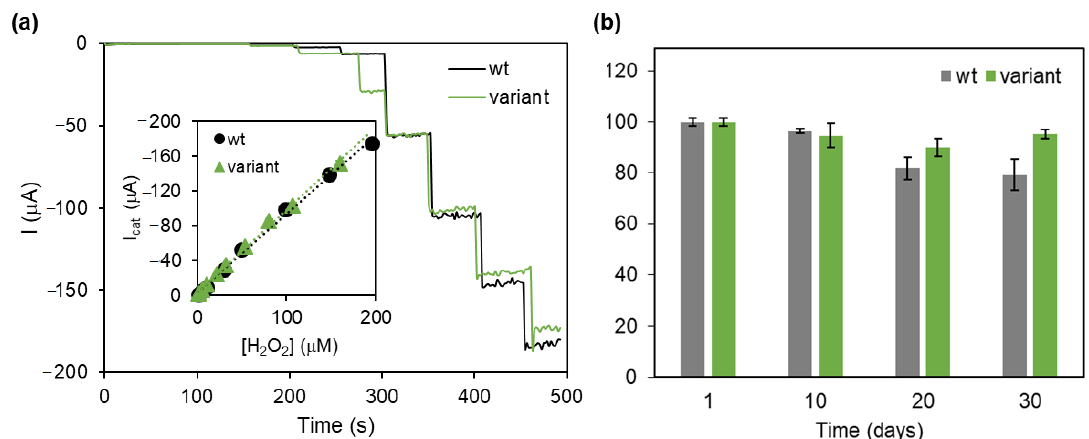
Figure 7. Catalytic response and stability of a dye-decolorizing peroxidase (DyP)/SAM/Ag biosensor used for H 2 O 2 quantification. ( a ) Amperometric response of wild-type (wt) and variant DyP-based biosensors to increasing H 2 O 2 . Inset : Calibration plots showing the linear dependence of the catalytic current on H 2 O 2 concentration. ( b ) Relative catalytic current response to 50 μM H 2 O 2 during storage for one month, measured on a batch of electrodes prepared on the same day (shelf-life). Reprinted from Barbosa et al. [67], Copyright (2020), with permission from Elsevier.